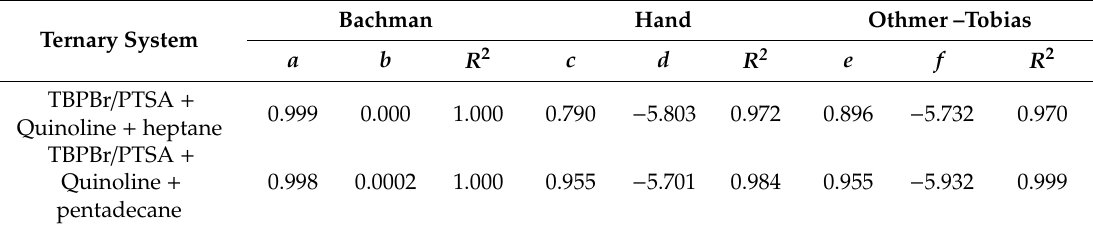
Table 6. Parameters of Bachman and Hand correlation for each ternary LLE system and the values of regression coe ffi cient.